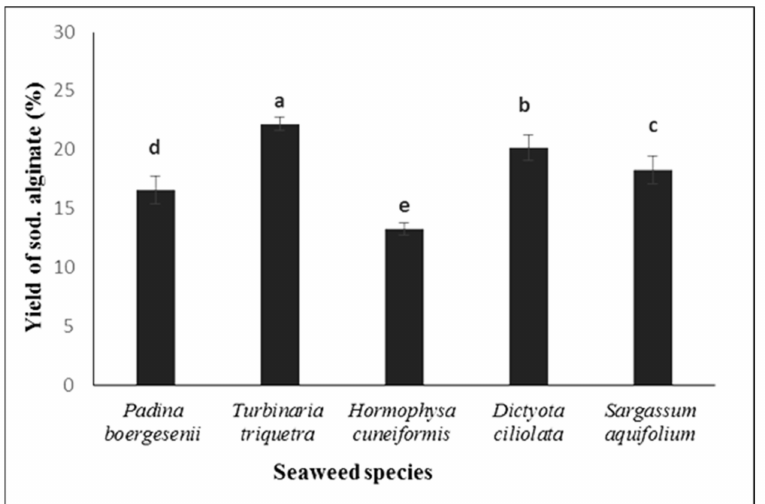
Figure 3. Extracted yield variations of sodium alginate (% DW) between the examined brown algae species. Different letters indicate a significant difference at the level of p ≤